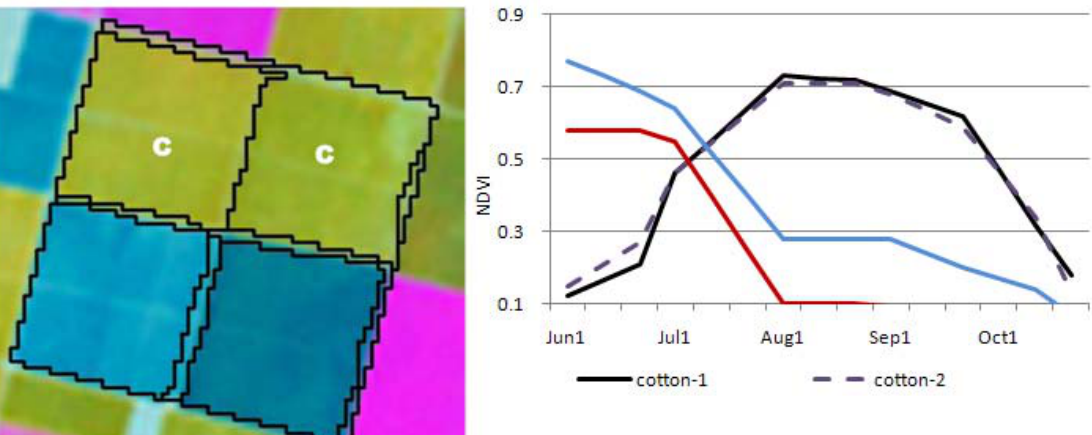
Figure 6. Landsat time series color composite image (left, PCA123) and NDVI time series plots (right) for all crop fields within Section 18S17E01. Paraquat was applied to two cotton fields. Two fields had NDVI time series values similar to cotton (identified as a white letter “C” on the image and black and purple dashed lines in the graph. Both fields closely matched signatures in the library (median difference ≤ 0.09). The specific fields where paraquat was applied were identifiable in this case. Determining which paraquat application was applied to which cotton field was not